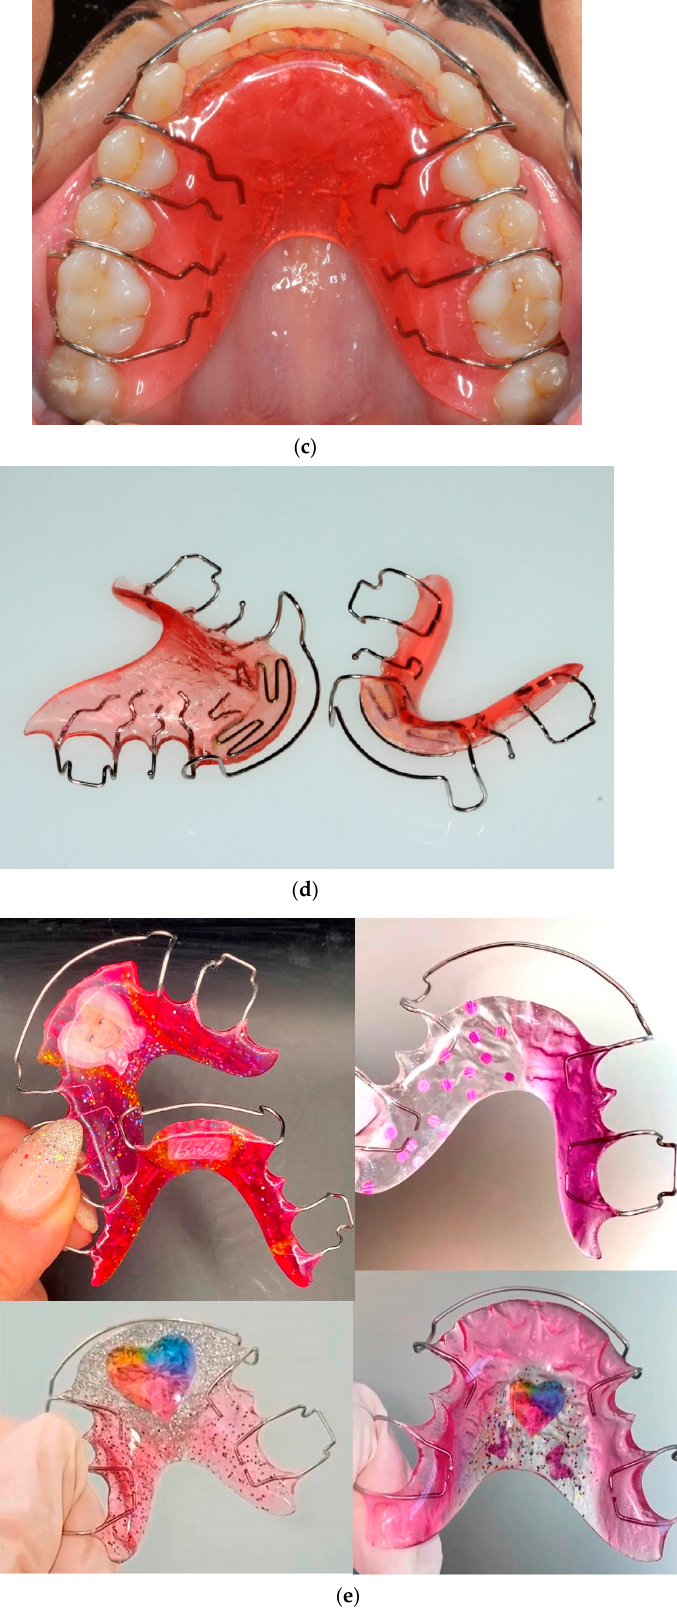
Figure 1. Hawley removable retainer. ( a ) Hawley occlusal view, ( b ) Hawley frontal view, ( c ) Hawley with ball slasps occlusal view, ( d ) Hawley with springs, ( e ) Hawley with colors and cartoon